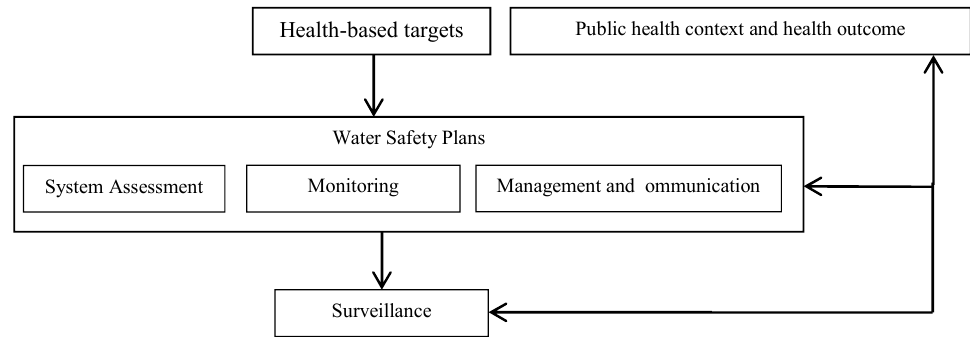
Fig. 1. Overview of the framework for safe drinking-water as set out in the guidelines for drinking-water quality